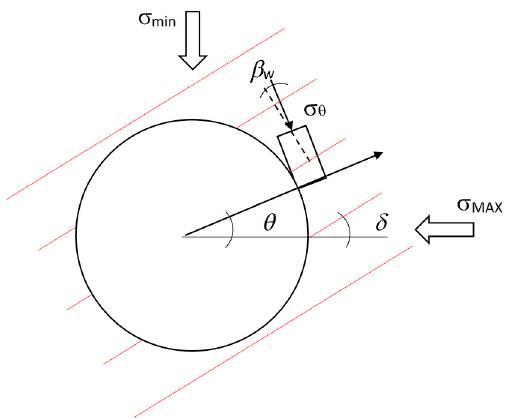
Figure 9. Definition of the angles δ , β w and ϑ around the wellbore for the analysis of slip. The red lines represent the weakness planes. The dotted line represents the normal to the planes.